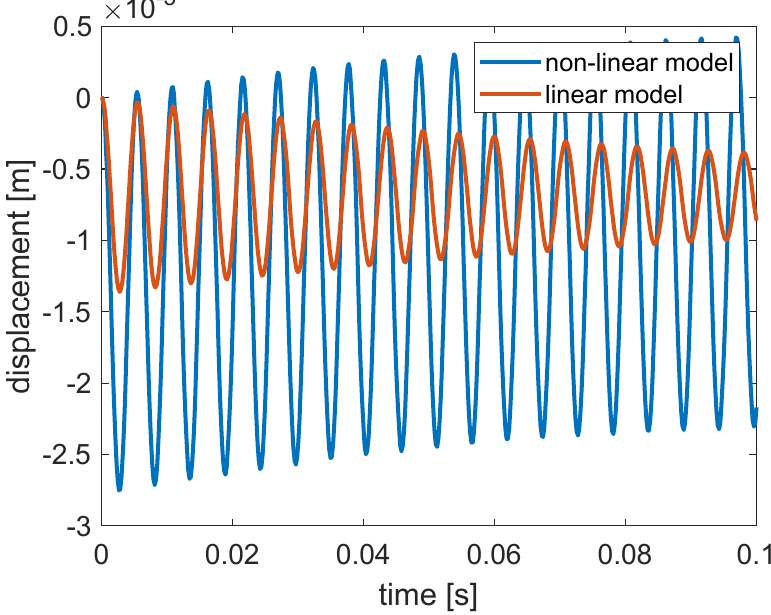
Figure 11. Free responses simulated by the non-linear and linear mechanical model of unit length of the reference ERS subjected to a constant force of 55 kN with null initial conditions.